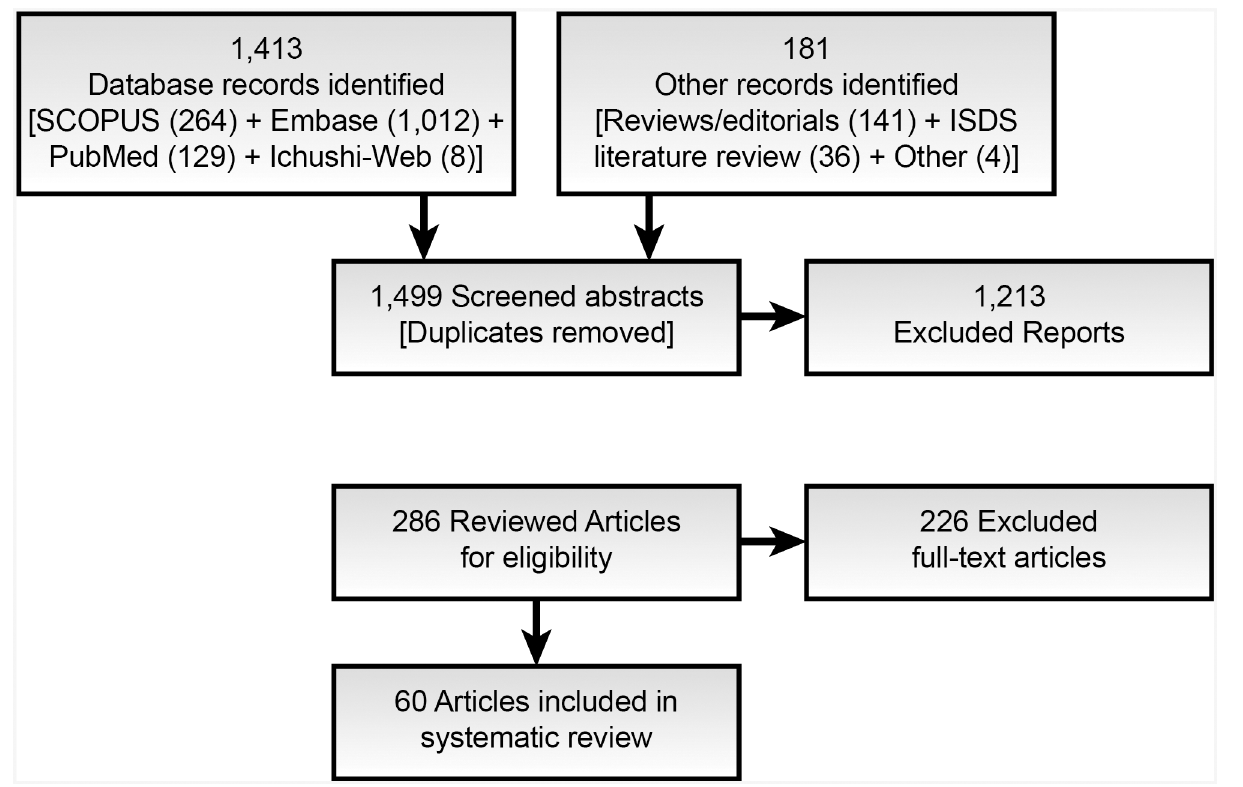
Fig 1. Flow diagram for the selection of literature reviewed. The abstract screening process resulted in 286 studies identified for detailed review of full- text articles. After this review, we further excluded studies that did not meet our definition of social media (e.g., Internet search, ProMED-mail) or discussed methods exclusively. We identified a total of 60 studies that met our eligibility criteria and addressed at least one of the two research questions. This process took over a year to complete because the authors donated their free time to review and analyze the